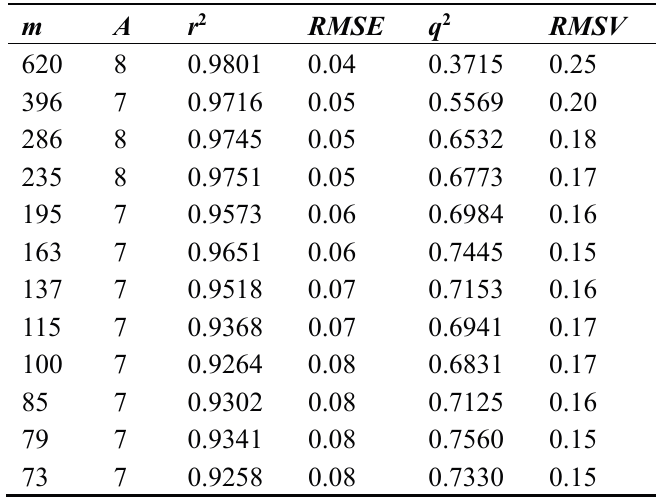
Table 1. The statistical results of variable selection by PLS